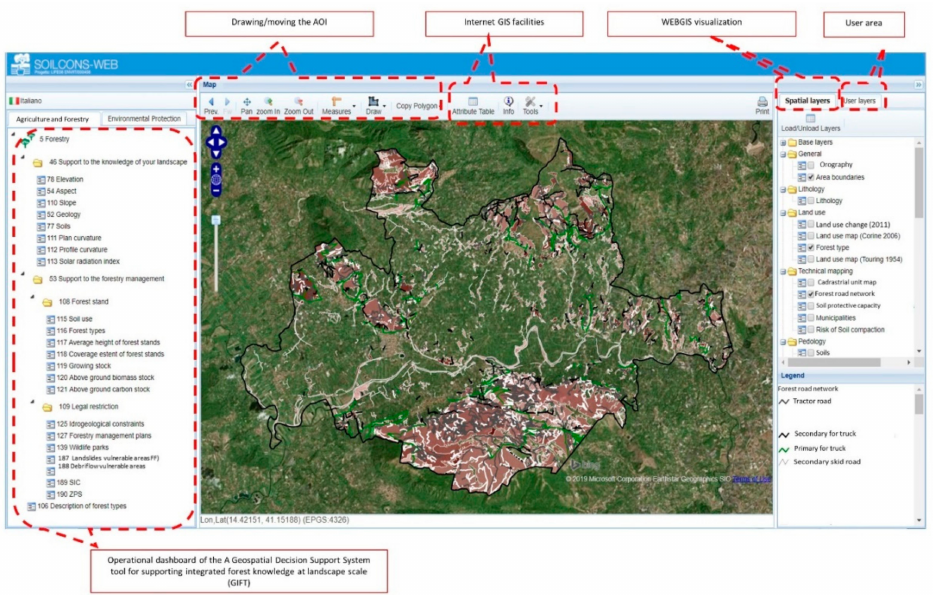
Figure 3. The dashboard in brief: the user can navigate through the platform and explore the five di ff erent sections (in